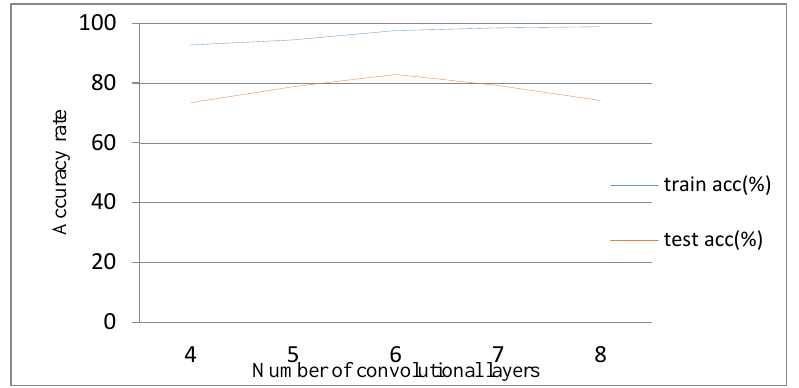
Figure 9. Comparison of network depth.